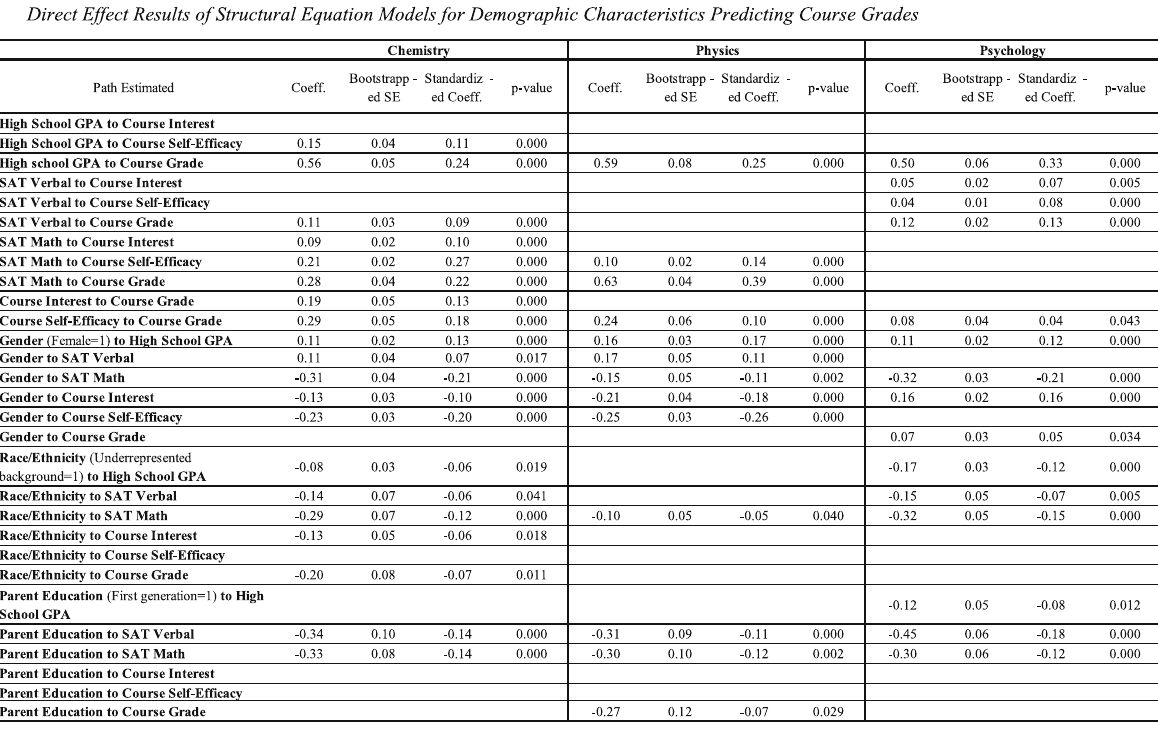
Table 6 Direct effect results of structural equation models for demographic characteristics predicting course